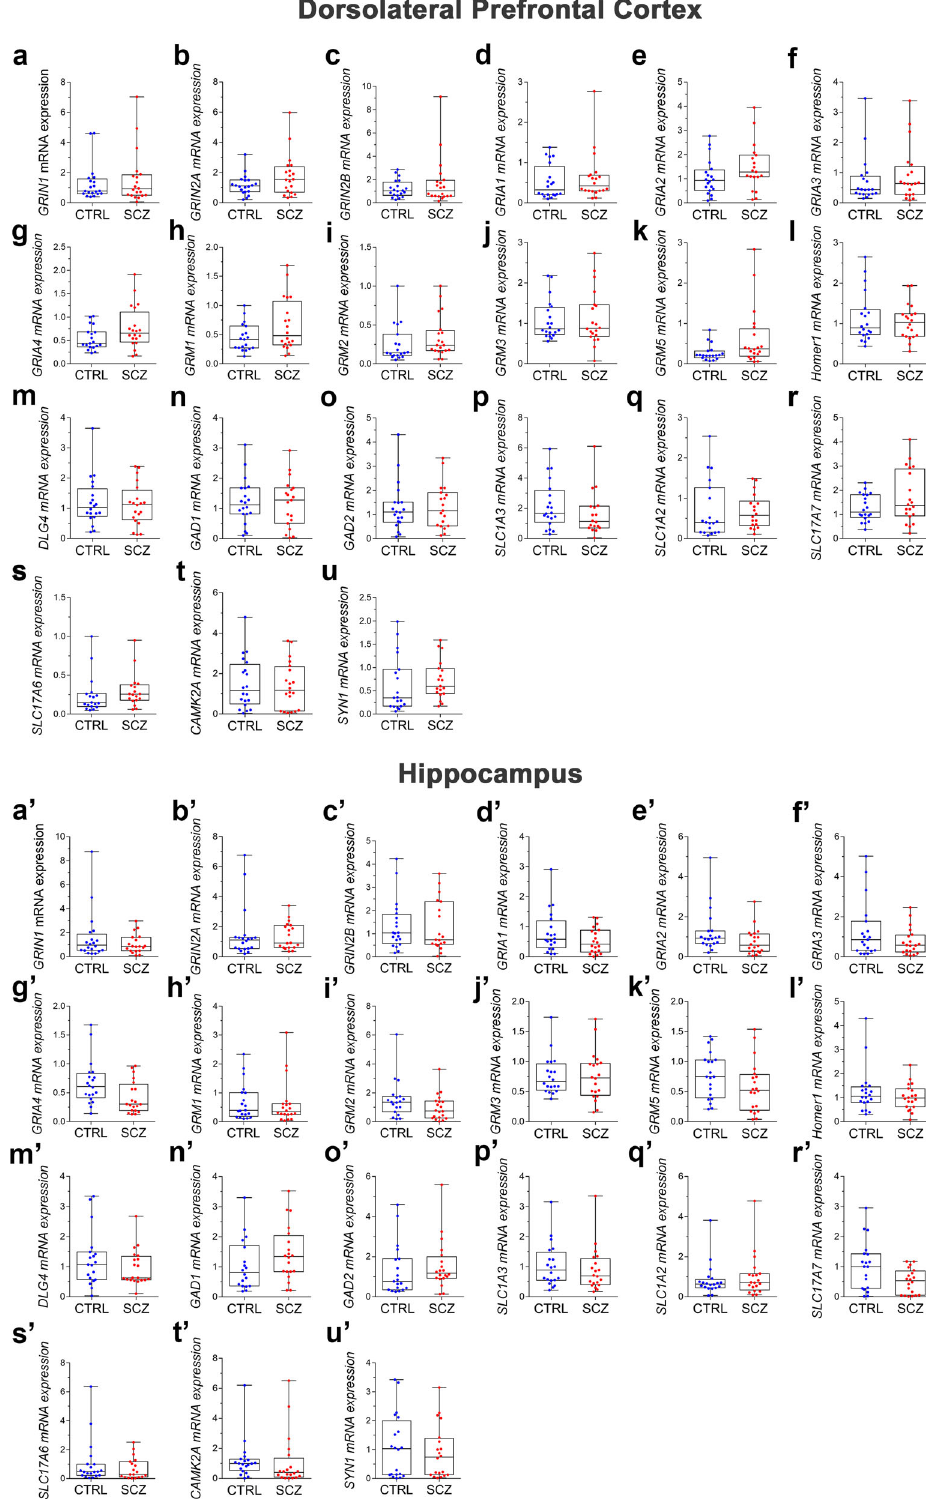
Fig. 2 Glutamatergic synapse-related gene expression in the post-mortem dorsolateral prefrontal cortex and hippocampus of control subjects and patients with schizophrenia. mRNA expression levels of a , a ′ GRIN1 , b , b ′ GRIN2A , c , c ′ GRIN2B , d – d ′ GRIA1 , e,e ′ GRIA2 , f , f ′ GRIA3 , g , g ′ GRIA4 , h , h ′ GRM1 , i , i ′ GRM2 , j , j ′ GRM3 , k , k ′ GRM5 , l , l ′ Homer1 , m , m ′ DLG4 , n – n ′ GAD1 , o , o ′ GAD2 , p , p ′ SLC1A3 , q , q ′ SLC1A2 , r , r ′ SLC17A7 , and s , s ’ SLC17A6, t , t ′ CAMK2A, and u , u ′ SYN1 in the a – u dorsolateral prefrontal cortex and a ′ – u ′ hippocampus homogenates of control (CTRL) and schizophrenia (SCZ) patients. mRNA expression was normalized to the mean of two housekeeping genes, β -actin and cyclophilin ( PPIA ), and expressed as arbitrary units. The number of examined samples is reported in Supplementary Table 4, for each considered